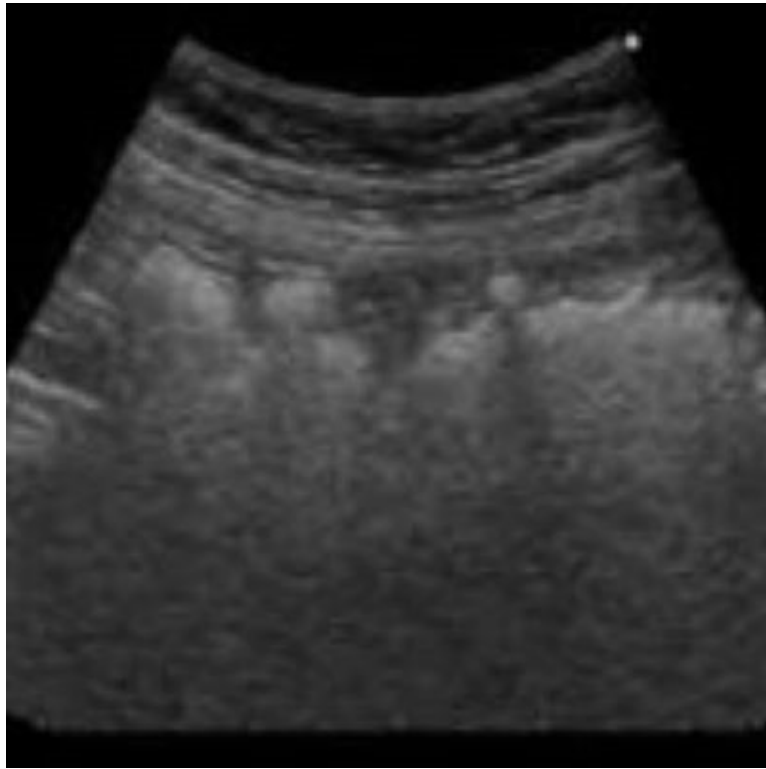
Figure 2. Resolution of intestinal inflammation.